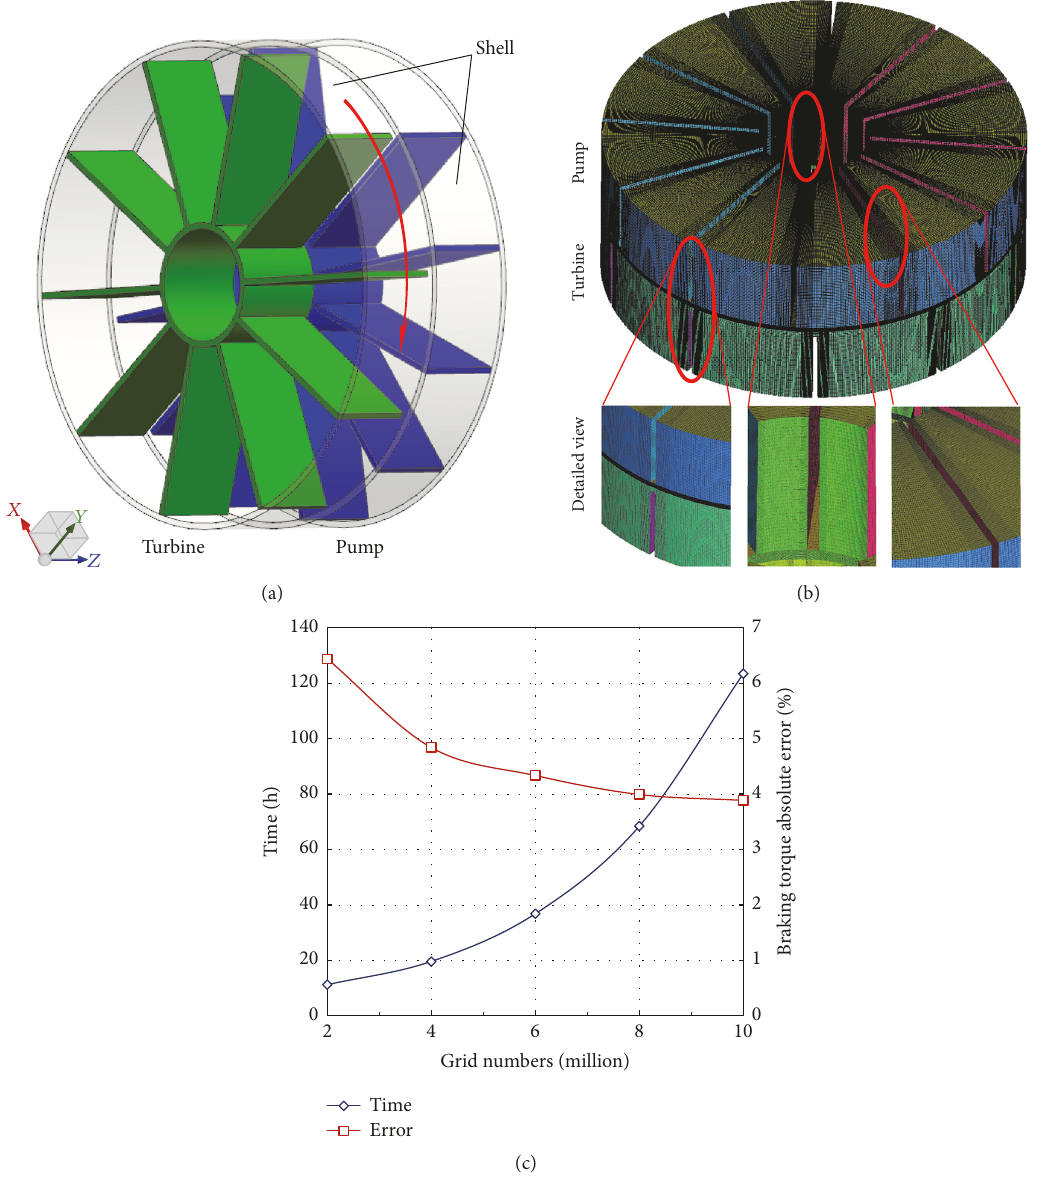
Figure 1: Hydraulic coupling. (a) 3D model; (b) grid layout; (c) grid independence test